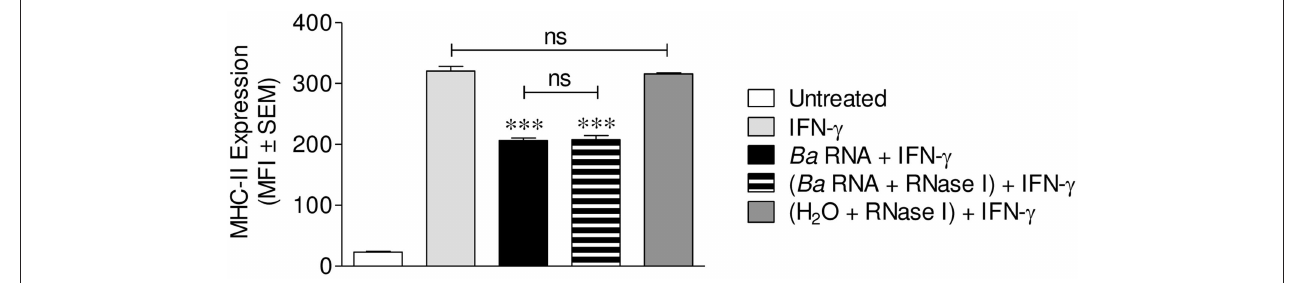
FIGURE 4 | Digested- B. abortus RNA is also able to down-modulate MHC-II. THP-1 cells were treated with B. abortus RNA (10 µ g/ml) or RNase I-treated B. abortus RNA in the presence of IFN- γ for 48h. Cells treated with RNase I were used as a control. MHC-II expression was assessed by flow cytometry. Bars represent the arithmetic means ± SEM of five independent experiments. MFI, mean fluorescence intensity; ns, non-significant. *** P < 0.001 vs. IFN- γ -treated cells.